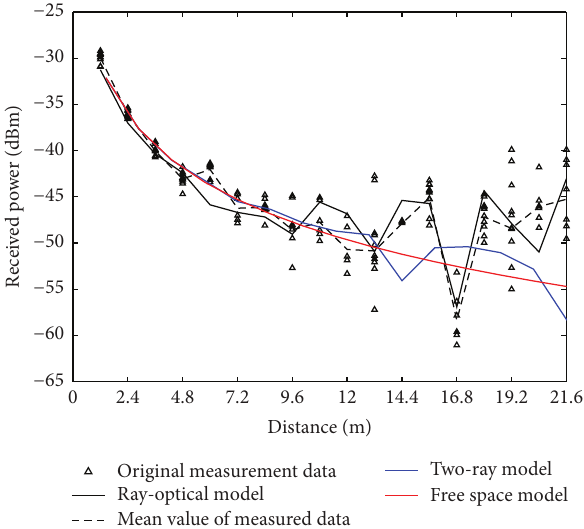
Figure 7: Received power versus link distance derived from ray- optical model, free space model, two-ray model, and measurements on floor 2.